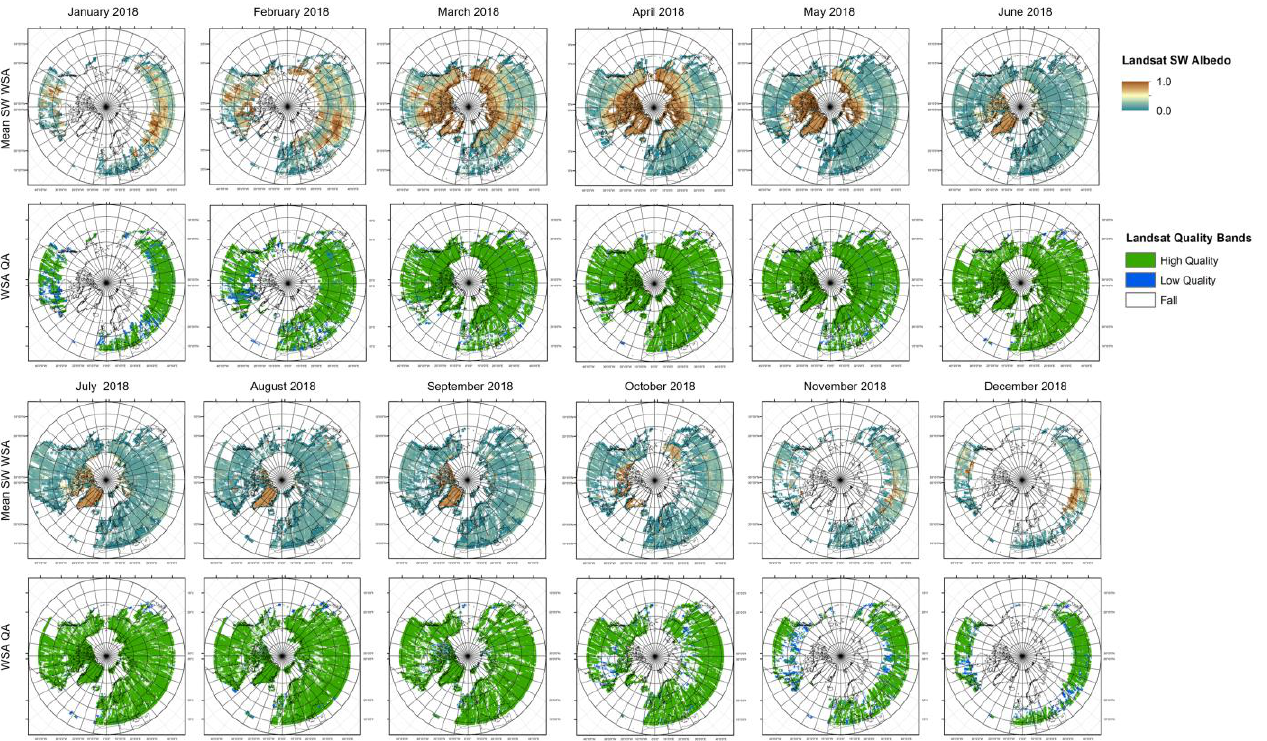
Figure 2. Monthly average white-sky albedo across the circumpolar domain for 2018 with associated QA metrics. The albedo and QA values have been aggregated to 500 m for the purpose of static visualization. The missing data, primarily occurring in November-February across the northern- most regions result from insufficient solar illumination due to polar night. regions result from insufficient solar illumination due to polar